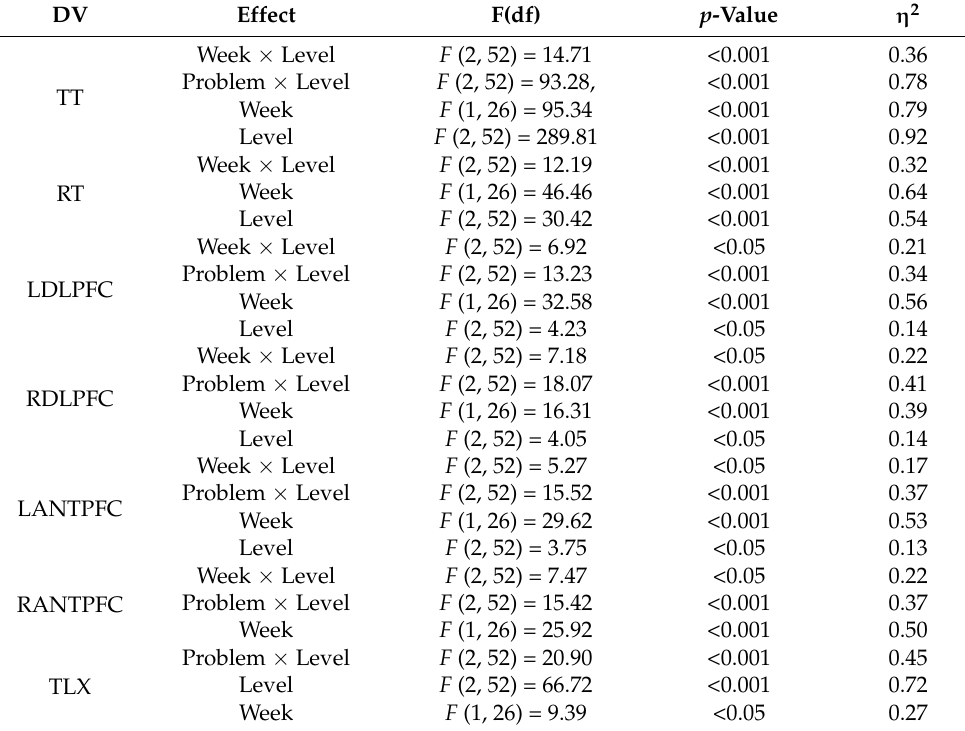
Table 1. Summary of repeated-measures factorial ANOVA results with interaction effects and main